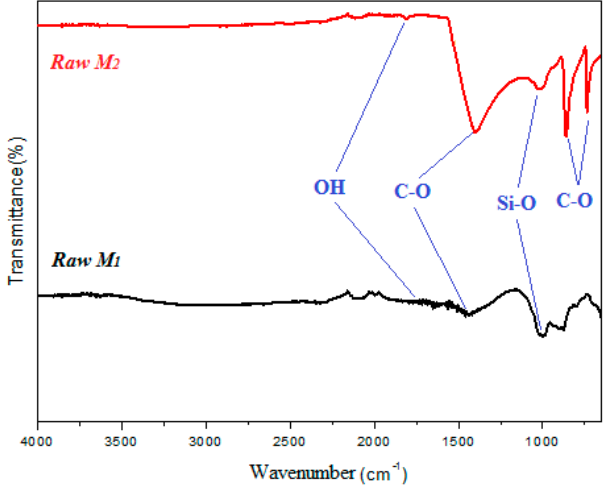
Figure 3. FT–IR spectra for the raw materials M 1 and M 2 .